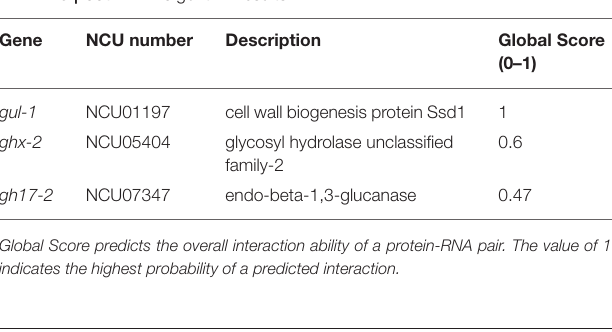
TABLE 3 | CatRAPID algorithm results.